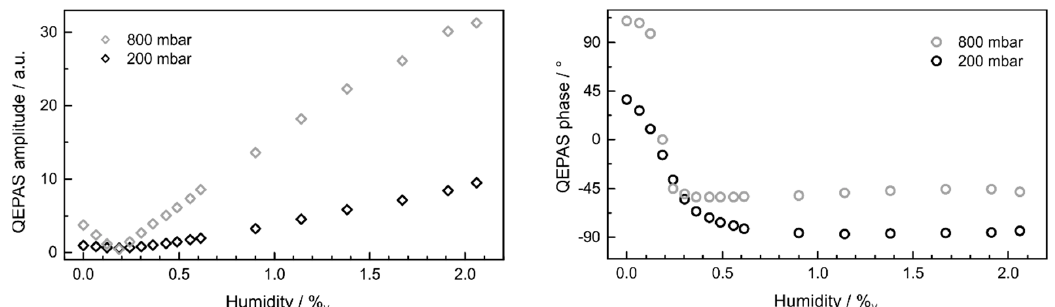
Figure 2. Amplitude ( left ) and phase ( right ) of the QEPAS signal of 20 ppm CO in N 2 at 200 mbar and 800 mbar at varying humidities (given as volume fraction). The temperature of the gas was 296 K.